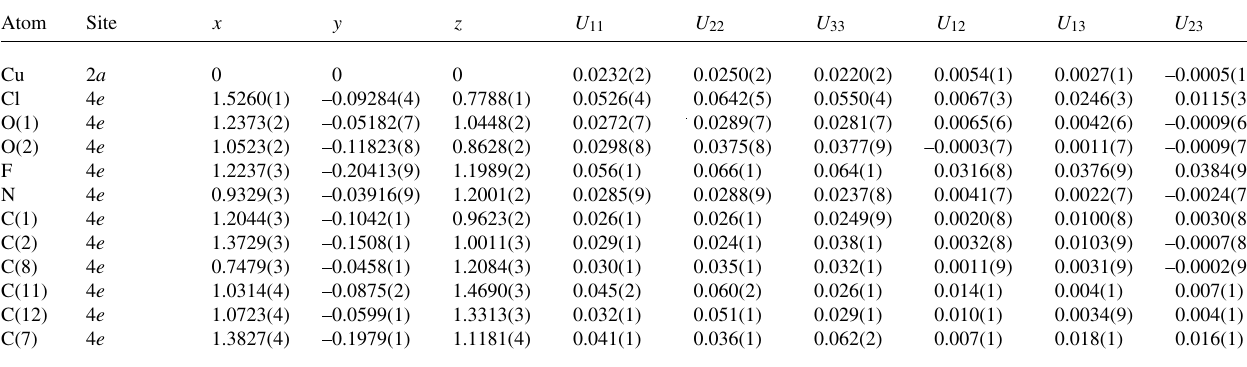
Table 3. Atomic coordinates and displacement parameters (in Å 2 )